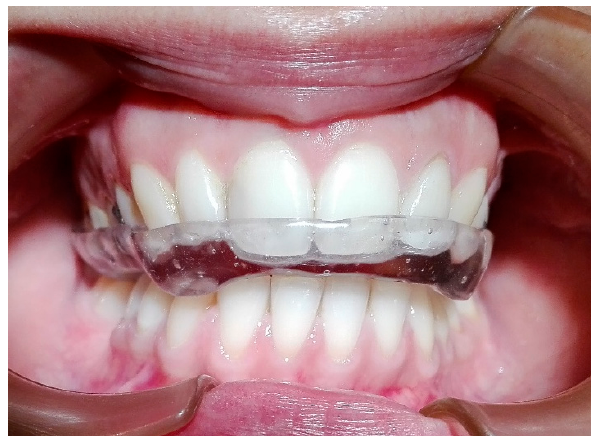
Figure 6. Occlusal splint, with uniform and bilateral dental contacts.